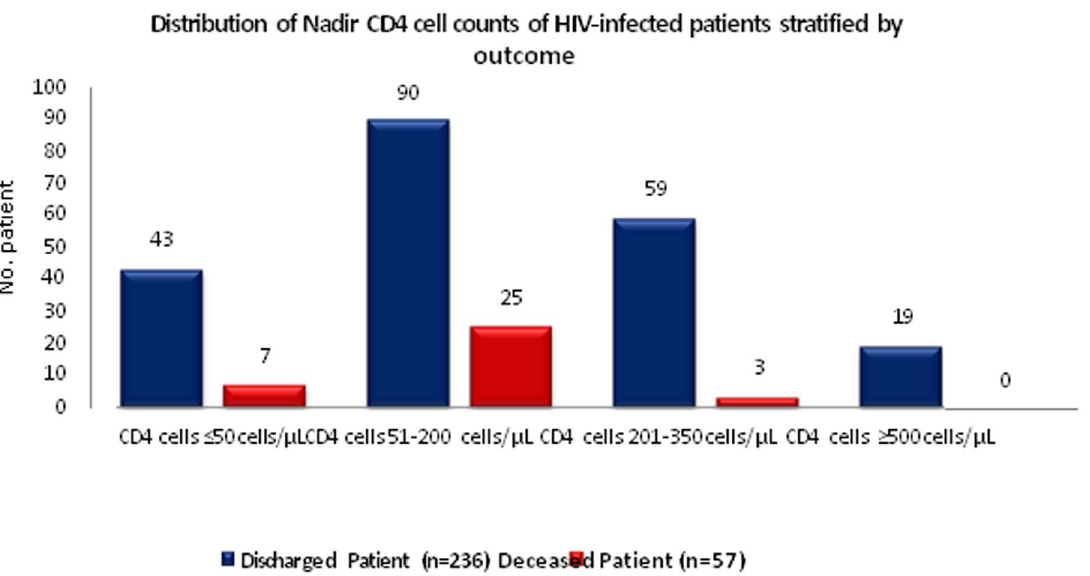
Fig. 1. Distribution of Nadir CD4 cell counts of HIV-infected patients stratified by outcome.